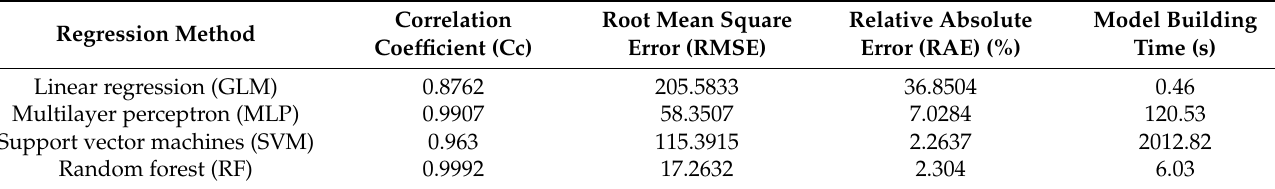
Table 5. Results of application of regression